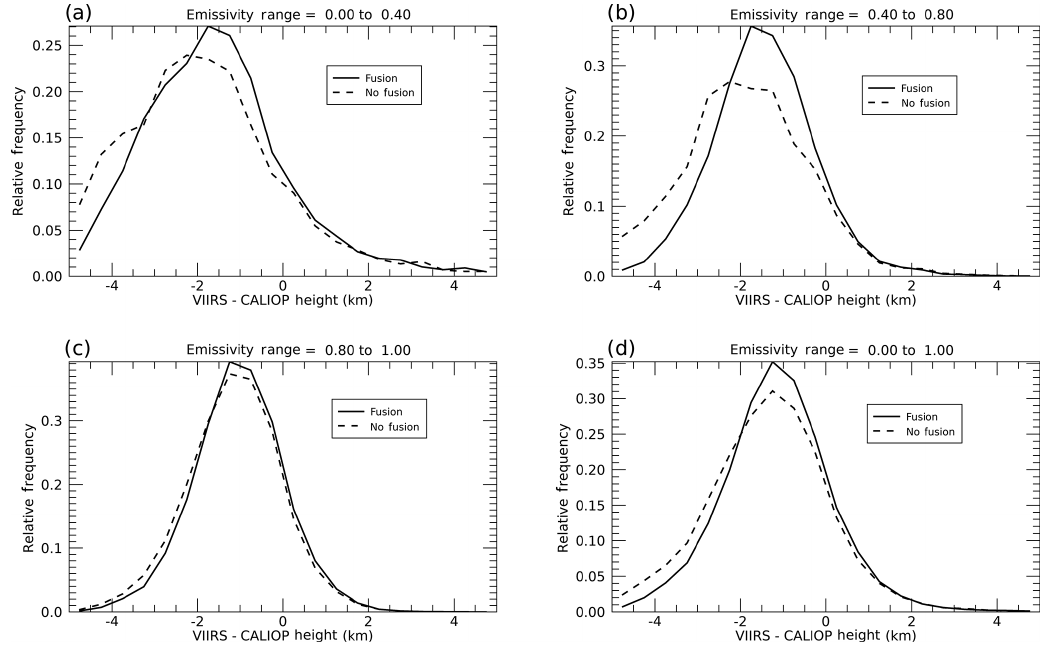
Figure 4. Bias distribution of cloud top height between S-NPP VIIRS and CALIPSO/CALIOP for emissivity ranges of (a) 0 to 0.4; (b) 0.4 to 0.8; (c) 0.8 to 1.0; and (d) 0 to 1.0. Solid and dashed lines indicate data with and without fusion channels.